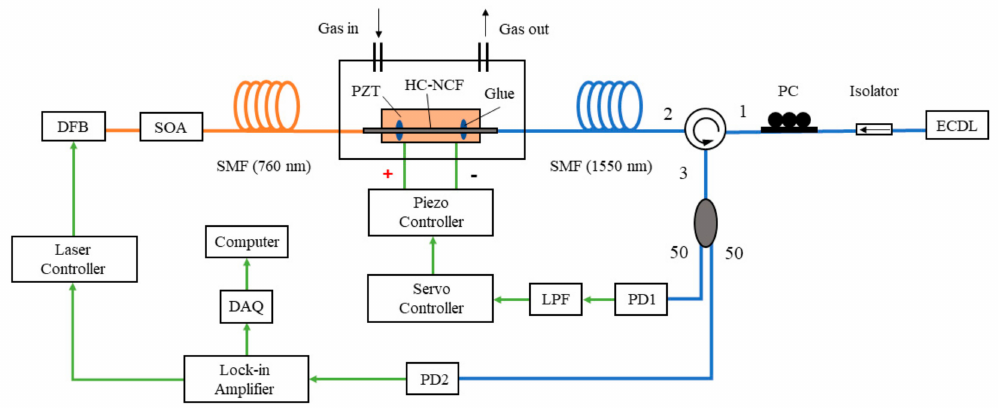
Figure 4. Experimental setup of oxygen detection based on PTI with a HC-NCF. PC, polarization controller; LPF, low pass filter; PD, photodetector; DAQ, data acquisition.